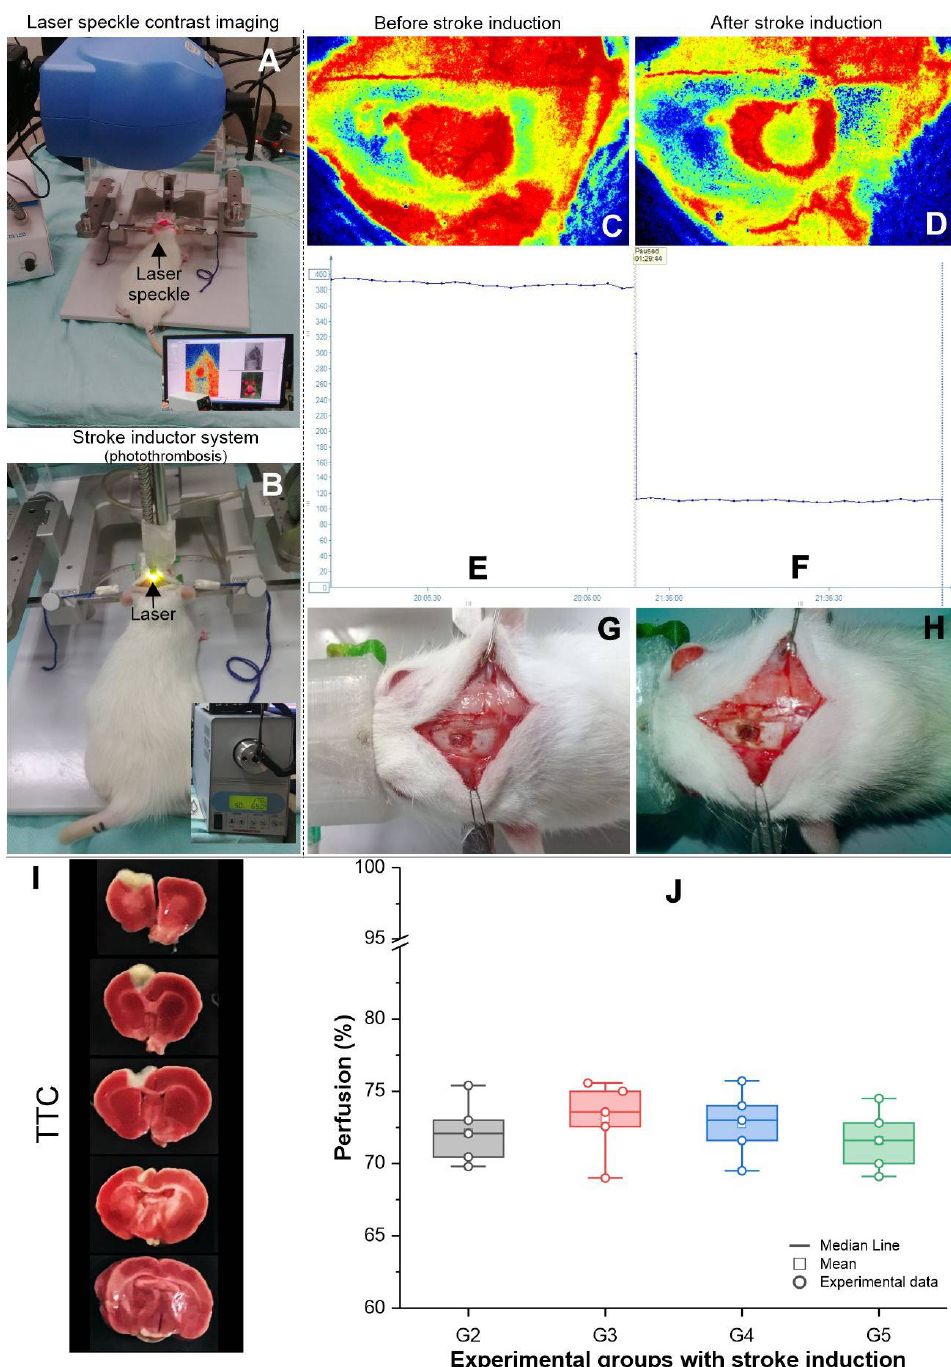
Figure 3. Evaluation of focal ischemic brain lesion by photothrombosis. ( A ) The laser speckle imagining system used for local blood perfusion evaluation; ( B ) The laser equipment used induce focal ischemic lesion by photothrombosis; ( C ) Baseline local blood perfusion before stroke induction; ( D ) Local perfusion after stroke induction; ( E , F ) The graphic representation of blood perfusion before and after stroke induction respectively; ( G , H ) Visualization of the animal’s skull with craniectomy before and after stroke induction, respectively; ( I ) Evaluation of stroke induction by TTC; and ( J ) Box plot of local blood perfusion change in the G2–G5 experimental groups. G2: Stroke group; G3: Stroke + MSC group; G4: Stroke + exercise group; G5: Stroke + MSC + exercise group; SD: Standard